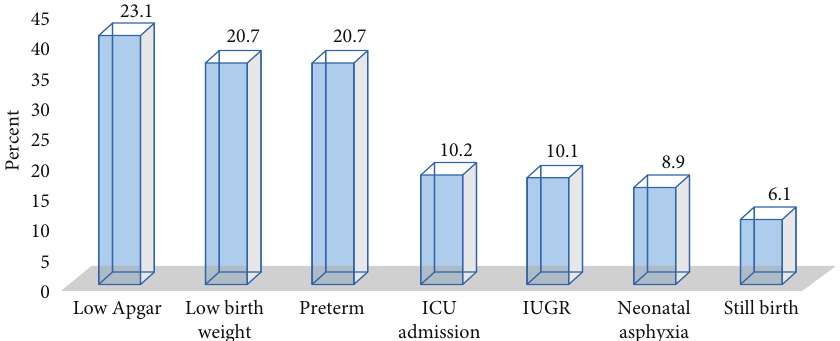
Figure 2: Magnitude of neonatal complications among hypertensive mothers at Suhul Hospital, Northwest Tigray, Ethiopia, 2019. Table 3: Binary and multivariable logistic regression results of factors associated with fetomaternal outcomes among women with hypertensive disorders of pregnancy at Suhul General Hospital, Northwest Tigray, Ethiopia, from July 01, 2014, to June 31, 2019.